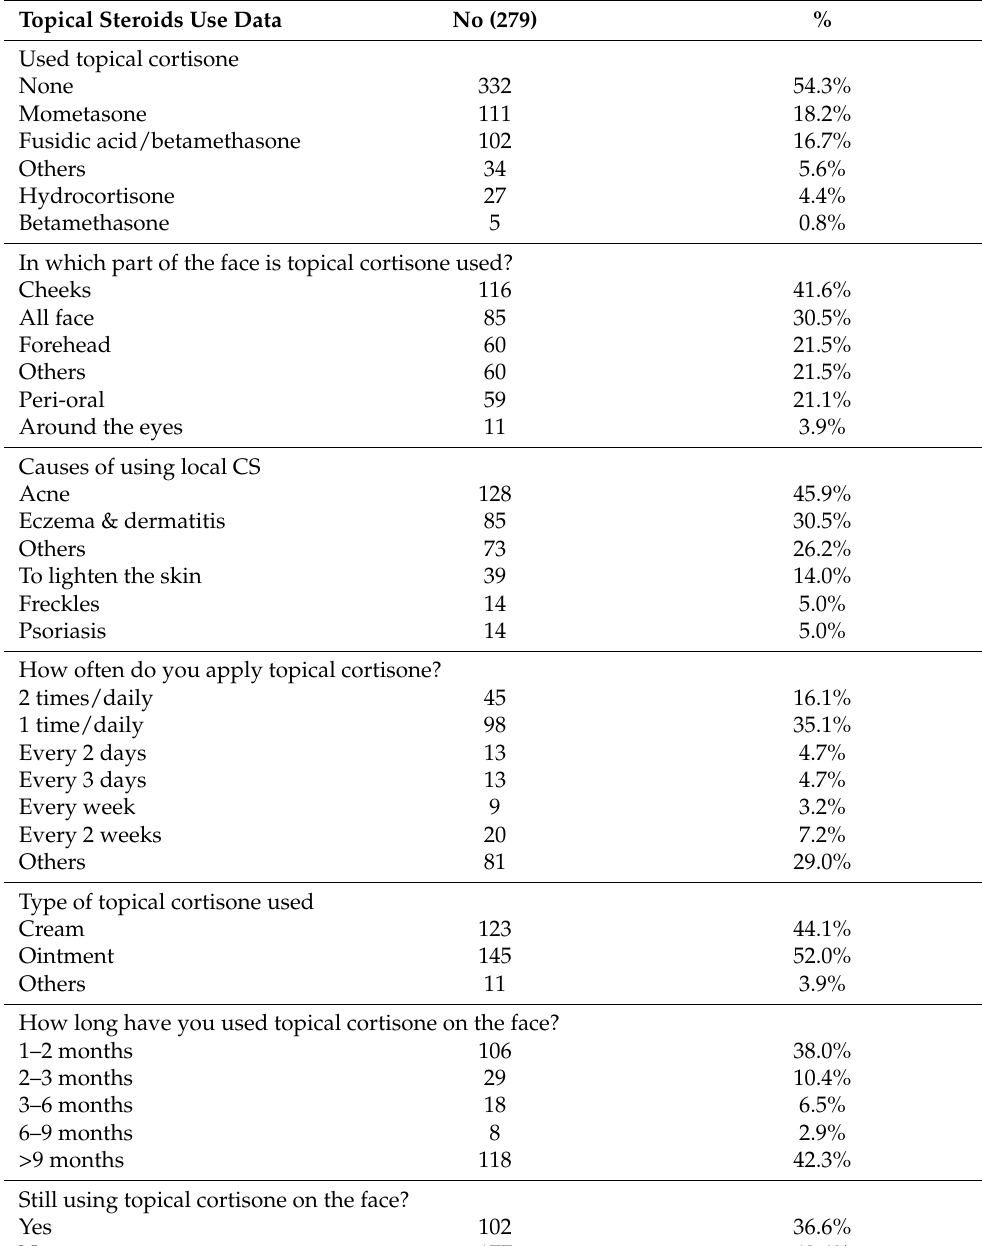
Table 1. Distribution of topical corticosteroids use among